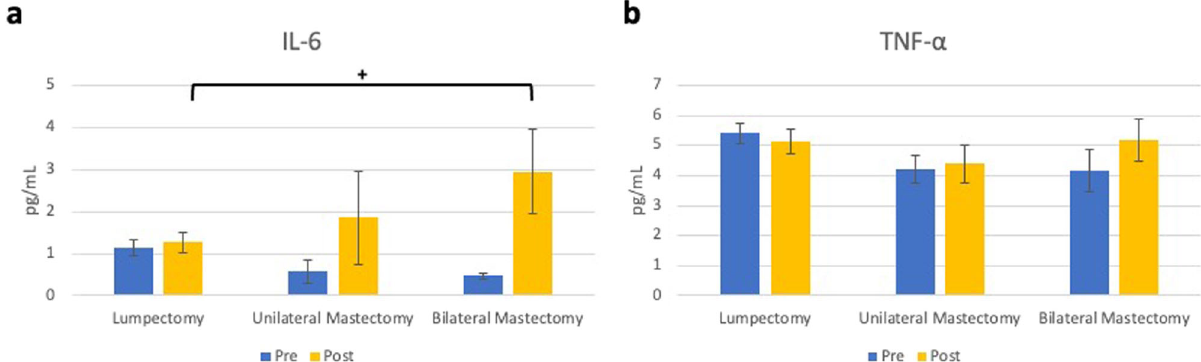
Fig. 2 Study 1 pre- and post-surgical in fl ammatory markers. Average levels of IL-6 ( a ) and TNF- α ( b ) are presented with error bars representing standard errors. Marginally signi fi cant differences between groups for post-surgical values using ANCOVA are represented by bars. ( + = p =